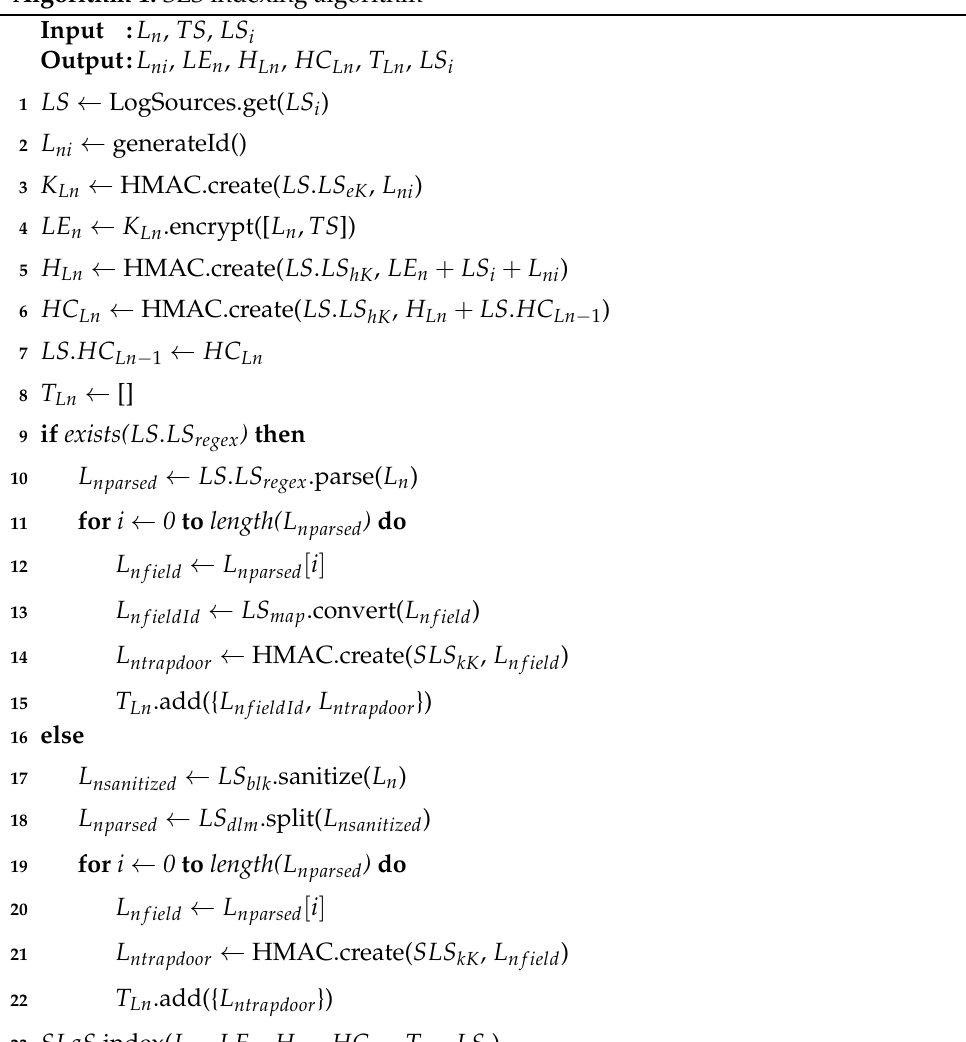
Algorithm 1: SLS indexing